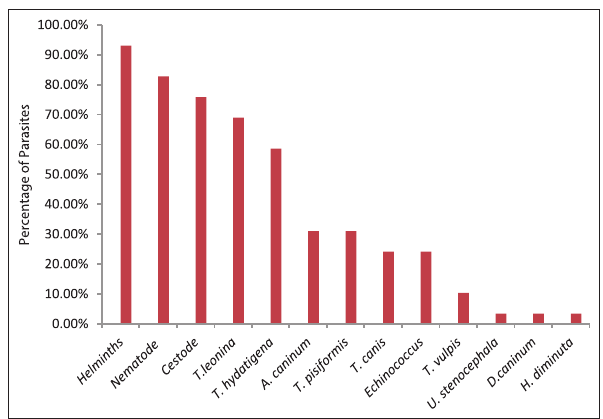
Figure-1: Percent abundance of individual helminth parasite recovered from the intestine of coyotes at postmortem examination of